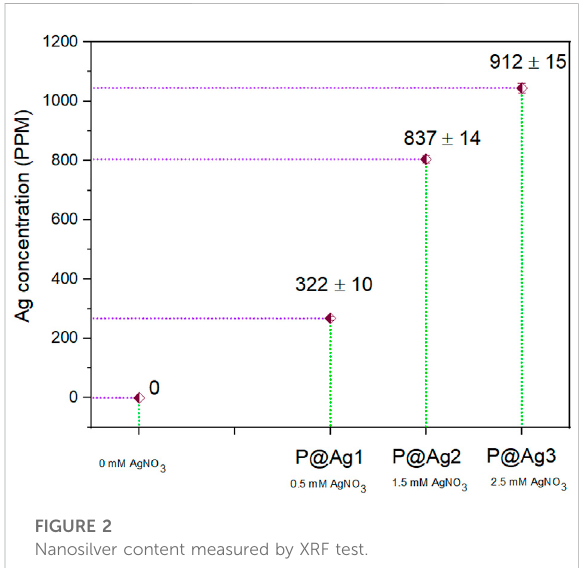
FIGURE 2 Nanosilver content measured by XRF